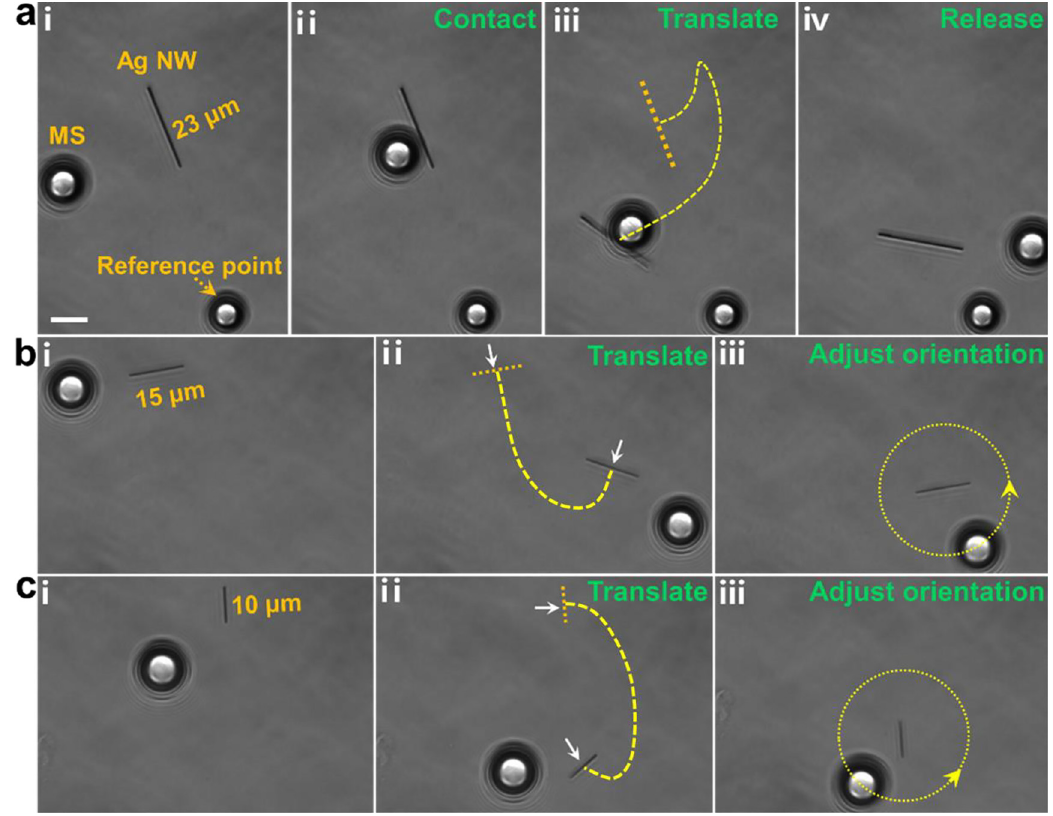
Figure 4: Microsphere-assisted translation of a single Ag nanowire.